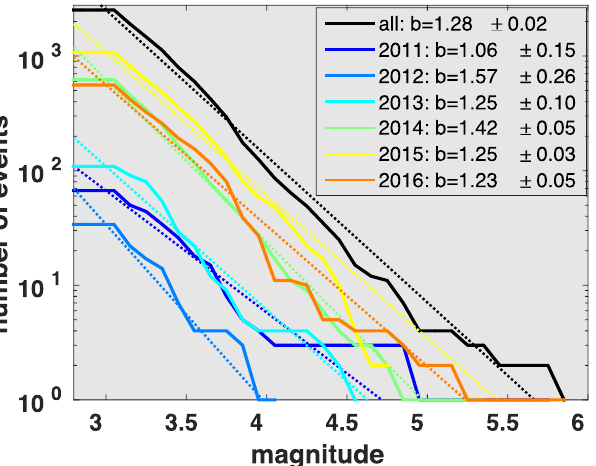
Figure 3. Magnitude frequency distribution for each year since 2011, and all years combined. The b-values and standard deviations are listed in the figure